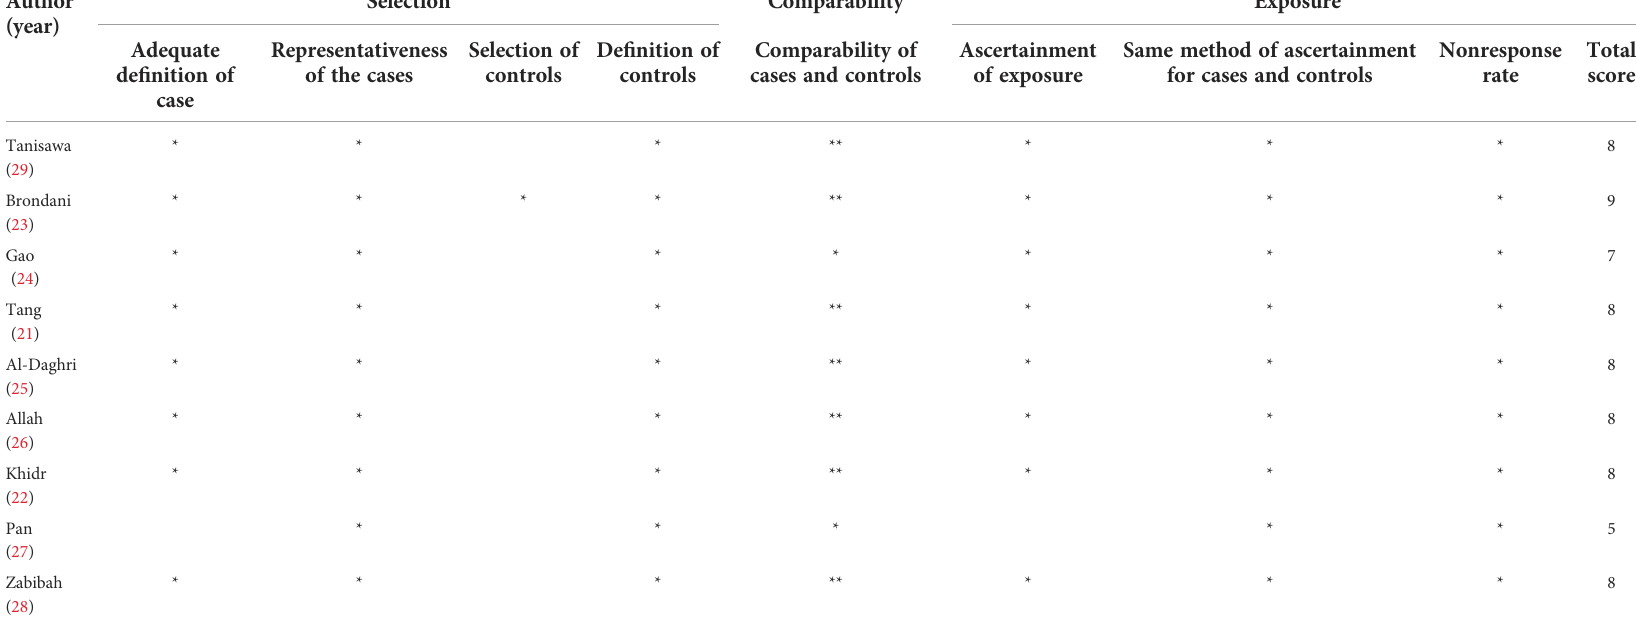
TABLE 1 The newcastle-ottawa quality assessment